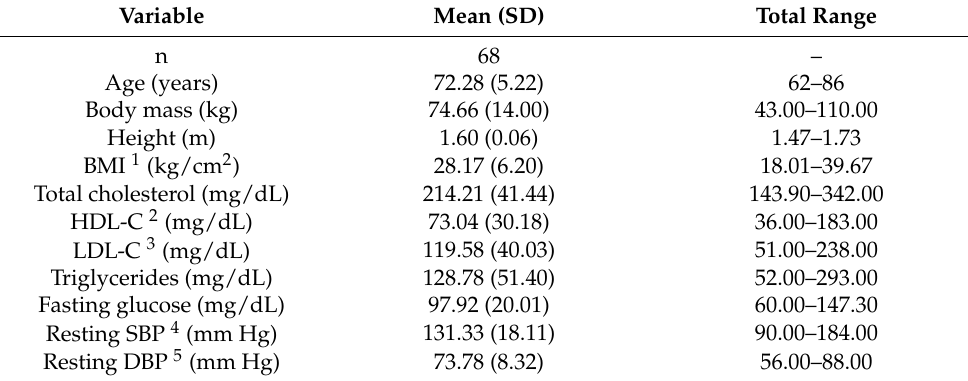
Table 1. Participants’ baseline